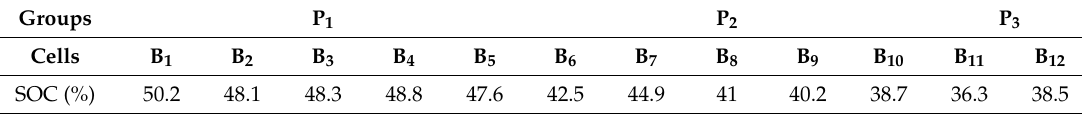
Table 3. The initial SOCs of 12 retired cells for charging equalization.